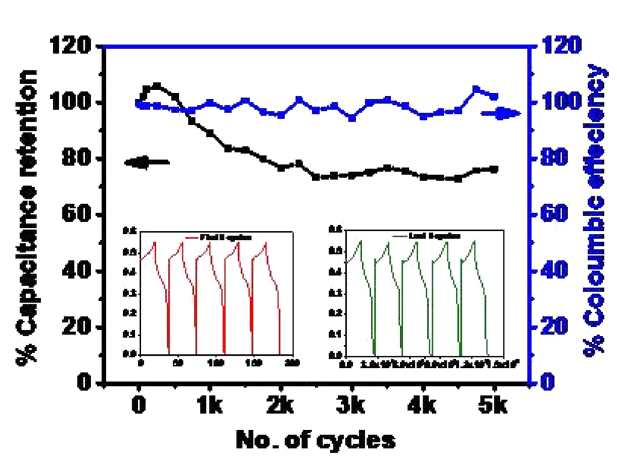
Figure 10. Capacitance retention and Coulombic efficiency as a function of a number of cycles for